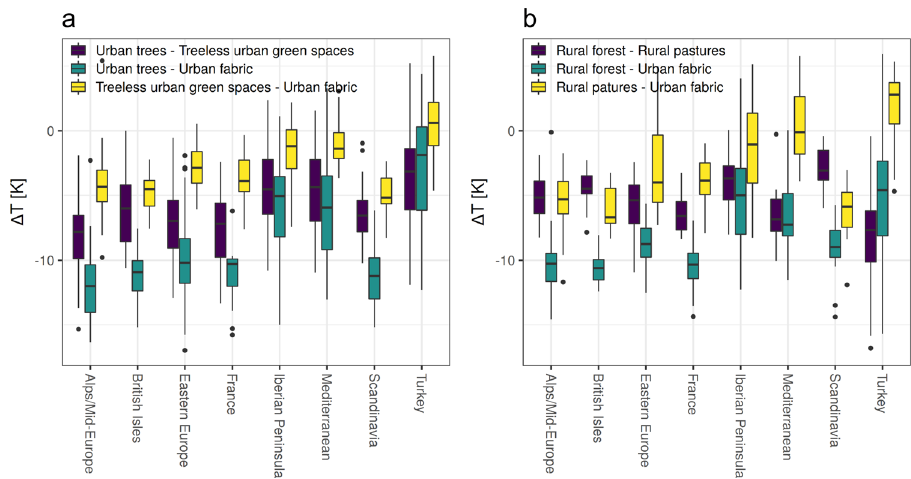
Fig. 3 Temperature differences between urban or rural vegetation and urban fabric. a Temperature differences between urban vegetation and urban fabric. b Temperature differences between rural vegetation and urban fabric (boxes show the fi rst and third quartile; whiskers show the largest/smallest values but do not extend beyond 1.5 times of the interquartile range; outliers are shown as separate points).